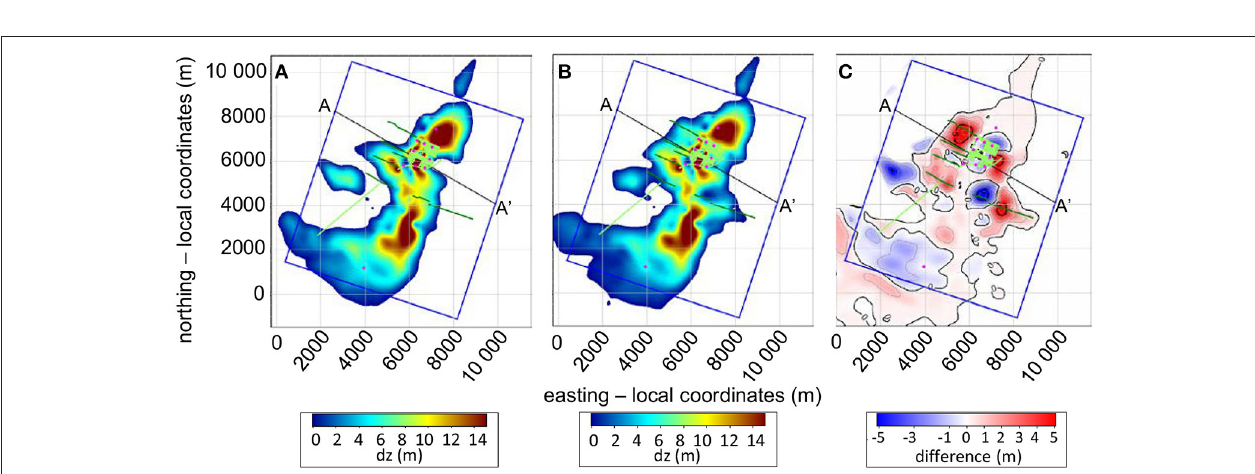
FIGURE 5 | Esker Sand and Gravel unit thickness map not using (A) and using (B) the seismic reflection data. Panel (C) is the difference between (B) and (A) . Black line is location of cross-section presented in Figure 8 .